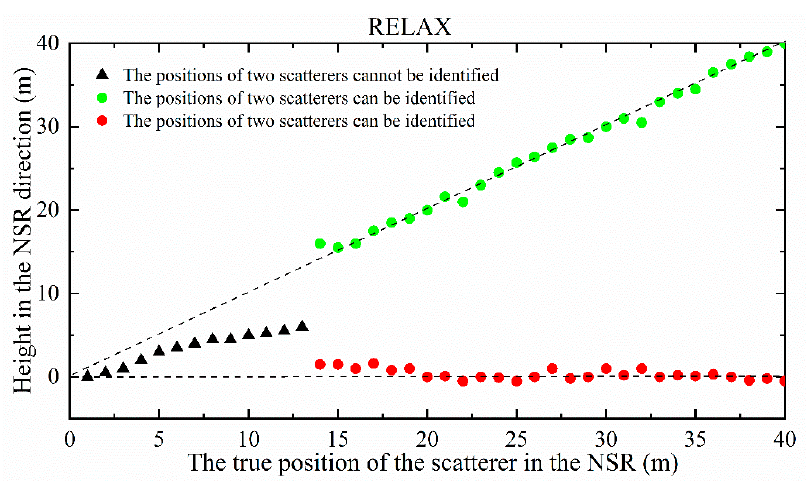
Figure 8. Simulation results of NSR resolution for RELAX.